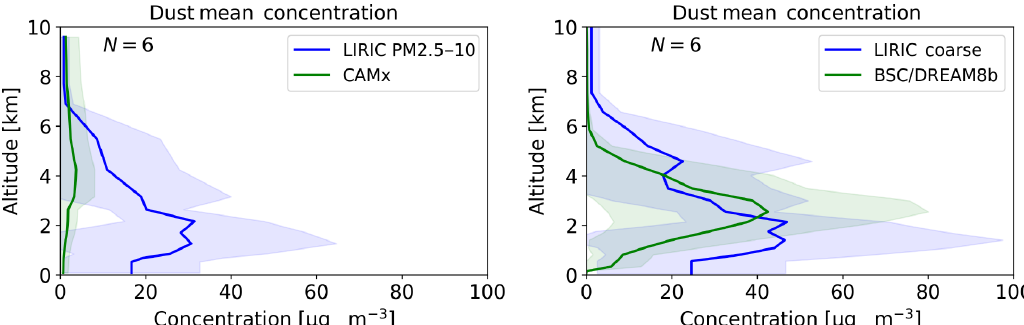
Figure 7. Comparison of CAMX (left) and BSC-DREAM8b (right) mean dust concentration profiles with LIRIC in the period 2013–2015. The mean PM 2 . 5 − 10 profile from LIRIC is compared with the mean soil PM 2 . 5 − 10 component profile from CAMx. The mean total dust profile from BSC-DREAM8b is compared against the coarse profile of LIRIC. The shaded regions correspond to 1 σ of each average profile. Differences between the LIRIC profiles are attributed to the interpolation of LIRIC in the resolution of each